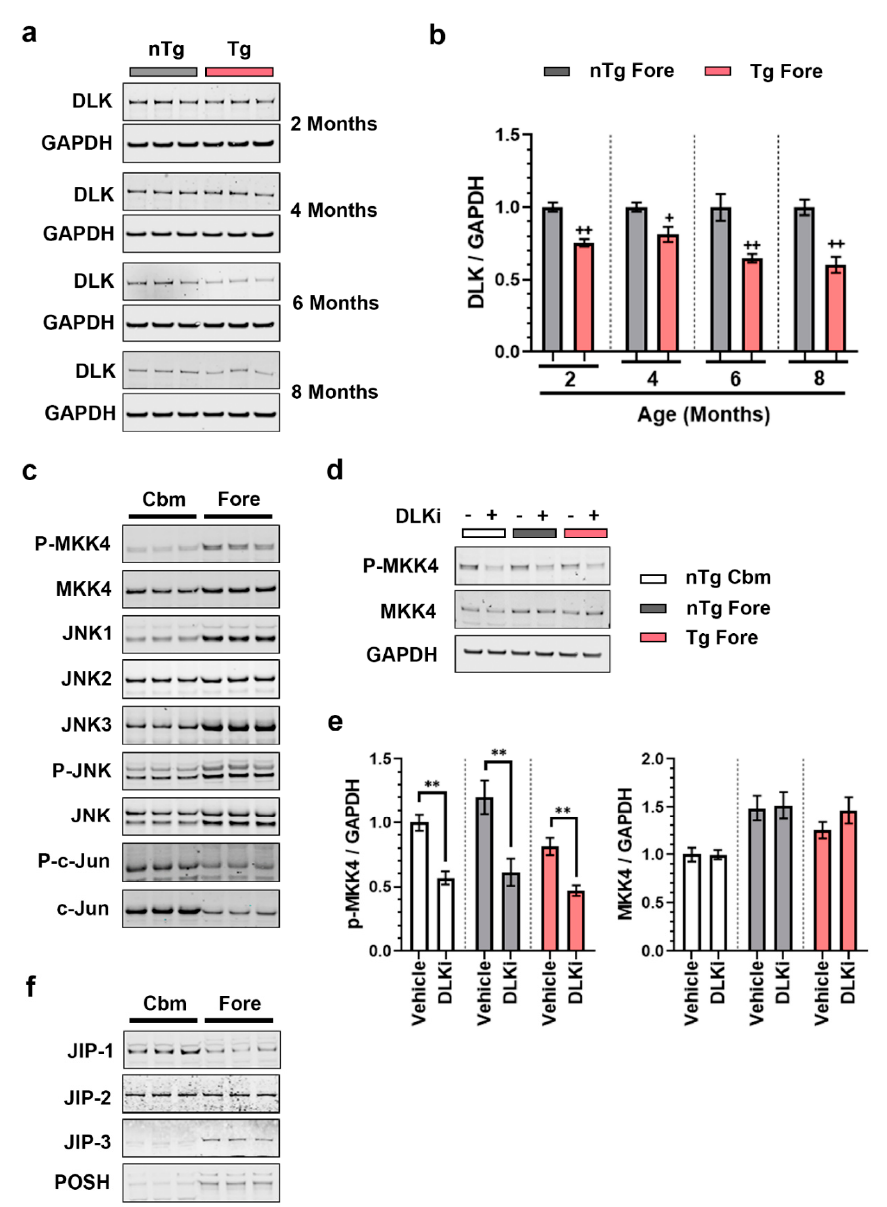
Figure 4. DLK is constitutively active in all the brain regions of adult mouse brain but has brain region specific scaffolding proteins. ( a ) Representative immunoblots of DLK from the homogenates obtained from nTg and Tg forebrain of 2, 4, 6, and 8 months old female mice. ( b ) Quantification of the immunoblots of DLK/GAPDH from the nTg and Tg forebrain homogenates from 2, 4, 6, and 8 months old female mice, plotted as mean fold change relative to nTg group of respective age cohort. Unpaired t -test. + p < 0.05, ++ p < 0.01, n = 6. ( c ) Immunoblots showing differential expression of DLK signaling components: p-MKK4, MKK4, JNK1, JNK2, JNK3, p-JNK, JNK, p-c-Jun, and c-Jun from cerebellum (Cbm) and forebrain (Fore) from 3–4 months old male WT mice. ( d ) Representative immunoblots of p-MKK4 and MKK4 in homogenates from nTg cerebellum (nTg Cbm), nTg forebrain (nTg Fore), and Tg forebrain (Tg Fore) of 7–8 months old female mice treated with 50 mg/kg of DLKi or vehicle QD for 7 days. ( e ) Quantification of the immunoblots of p-MKK4 / GAPDH and MKK4 / GAPDH from homogenates obtained from nTg cerebellum, nTg forebrain, and Tg forebrain of mice treated with vehicle or DLKi, plotted as mean fold change relative to vehicle group in the respective brain region. Unpaired t -test. ** p < 0.01, n = 6. ( f ) Immunoblots showing di ff erential expression of DLK sca ff olding proteins: JIP1, JIP2, JIP3, and POSH from cerebellum (Cbm) and forebrain (Fore) from 3–4 months old male WT